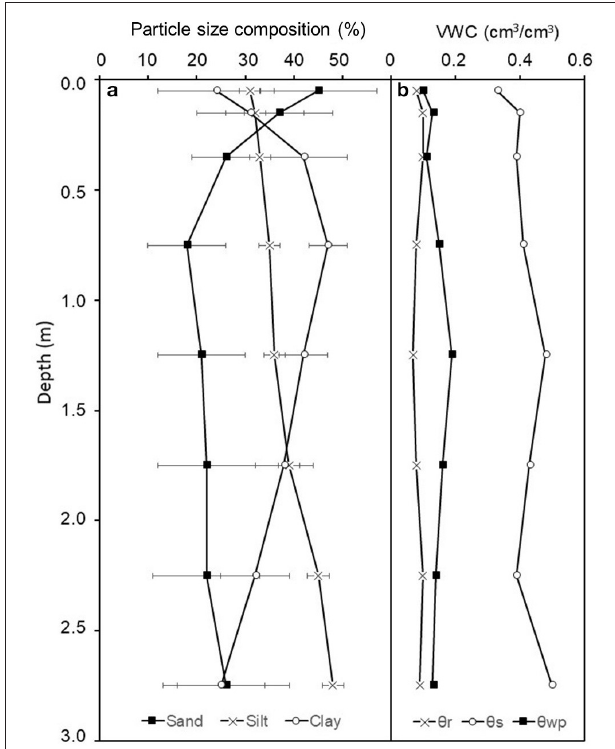
FIGURE 4 | (a) Soil sand, silt, and clay percentage for all treatment plots at Taliaferro County, Georgia. Values are mean ± 1 SE ( n = 16). (b) Soil water retention curve parameters for 0–0.1 and 0.1–0.2m, eight samples were collected and data points from all eight samples were used to create one soil water retention curve, and for soils below 0.2m, two samples were collected. Samples were collected in August 2013. Where θ r is the residual volumetric water content, θ s is the saturated volumetric water content, and θ wp is the volumetric water content at − 1.5 MPa, determined from soil moisture retention